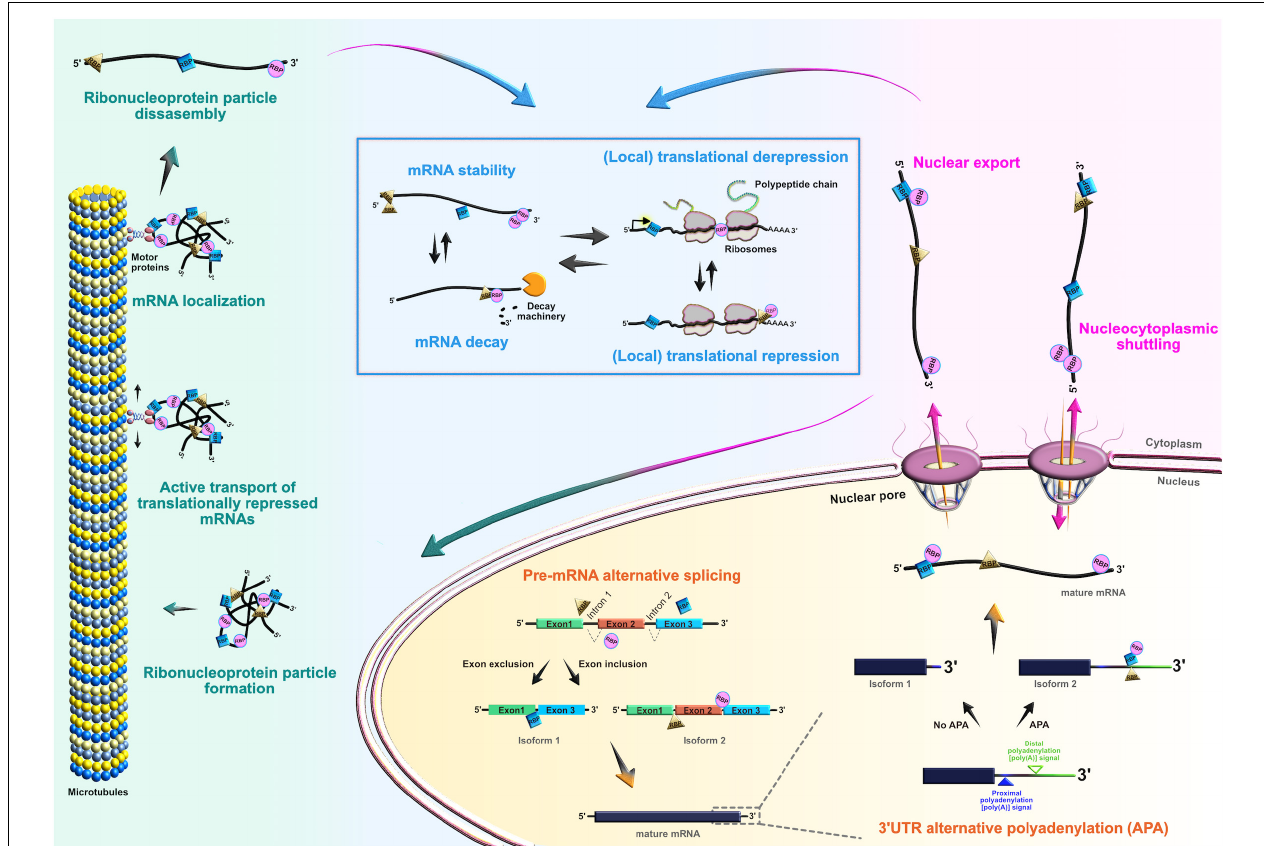
FIGURE 3 | Roles of RNA-binding proteins (RBPs) in the mRNA life-cycle. At the post-transcriptional level, RBPs actively control the entire life cycle of mRNAs in both progenitors and their neuronal and glial progeny. Posttranscriptional processing begins in the nucleus, where RBPs regulate pre-mRNA alternative splicing, 3 (cid:48) UTR alternative polyadenylation, and nuclear export of mature mRNAs. RBPs can also act as chaperones of target mRNAs, supporting their nucleocytoplasmic shuttling. In the cytoplasm, RBPs regulate transcript localization, stability, temporal silencing, and translation, ensuring proper spatiotemporal control of protein